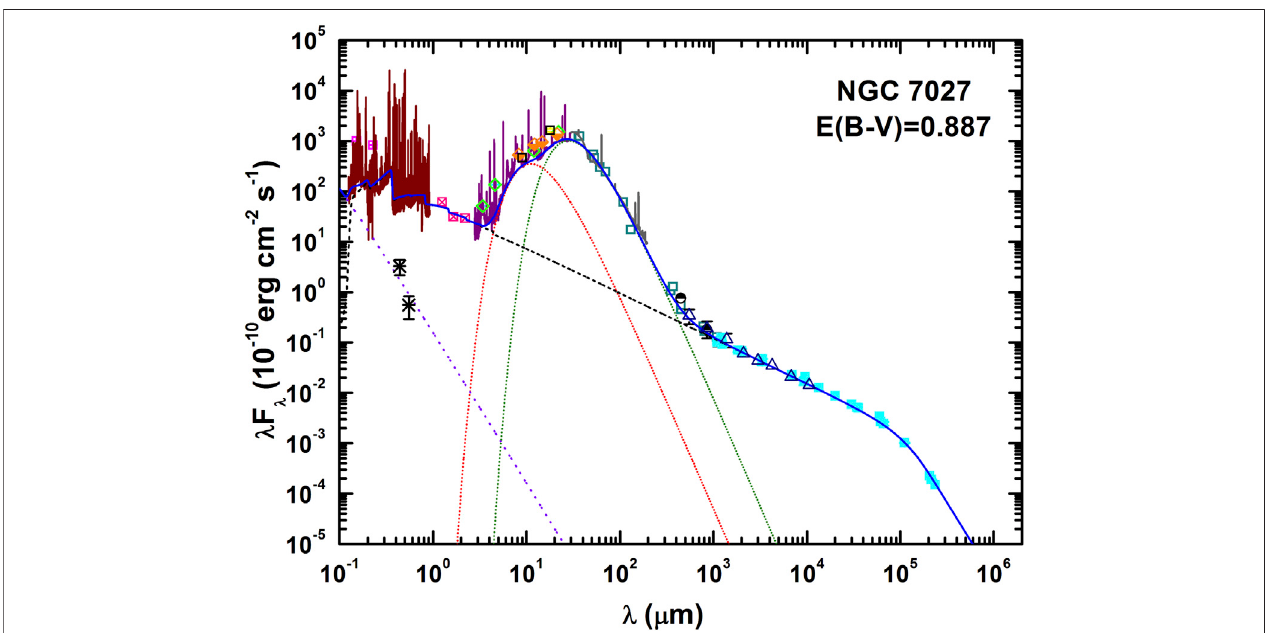
FIGURE 2 | Spectral energy distribution of the planetary nebula NGC 7027 from wavelength 0.1 to 1 m. Various symbols represent photometric measurements and the lines are spectroscopic observations. The red and green curves are approximate fi ts to the dust continuum. The dashed line covering the entire spectrum is a model bound-free and free-freeemissionfromtheionizednebula.Thedashed lineinthevisibleand UVregion isanapproximate fi ttothecentralstarcontinuum. TheUV and optical photometry and spectroscopy has been corrected for circumstellar/interstellar reddening with E (B-V) = 0.887. Figure courtesy of C.H.